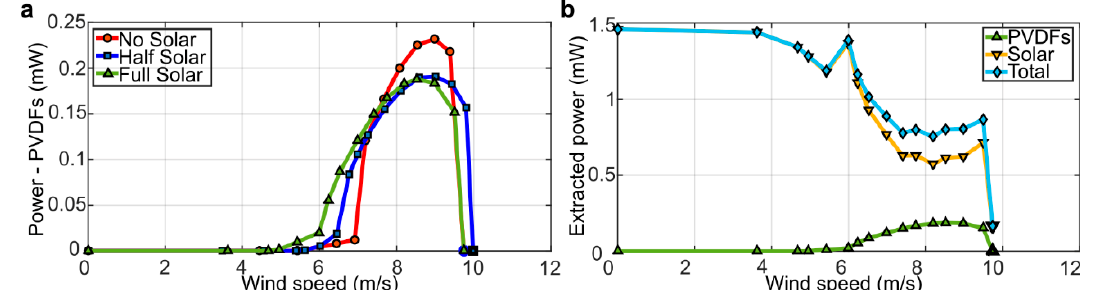
Figure 11. Measured power generation for the inverted flags: ( a ) root-mean-square (RMS) power generated from the four PVDF elements at different wind speeds; ( b ) total extracted power from the full-solar flag including the contributions from the four PVDF elements and the two full-solar panels (at 1.8 klx constant illumination).